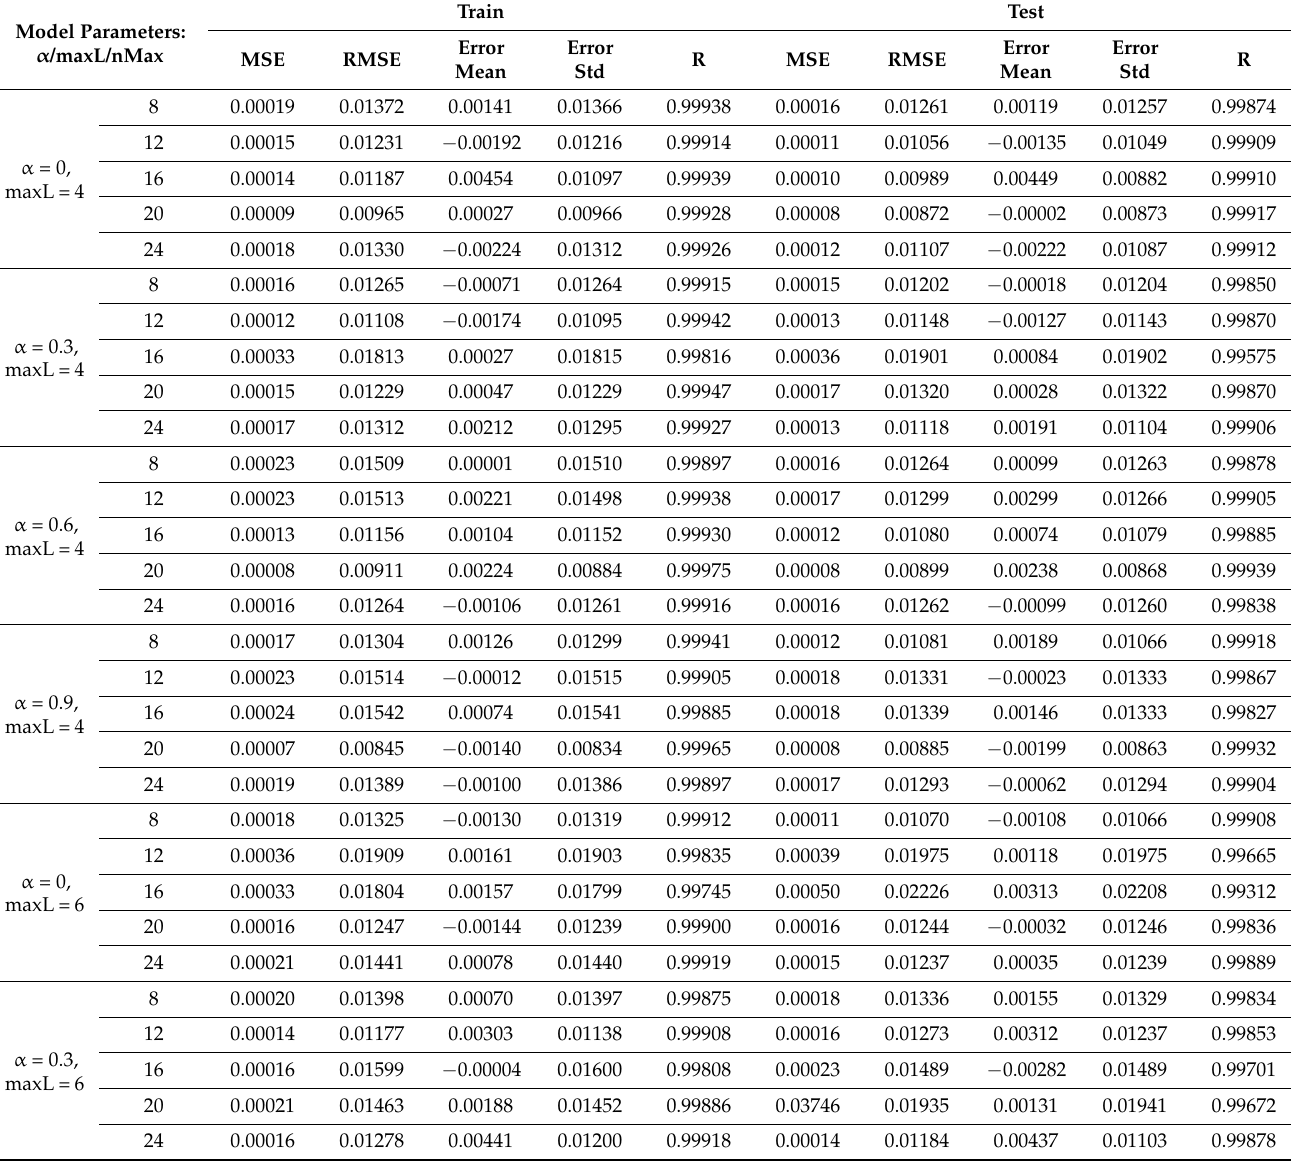
Table 1. The model performances for different values of model